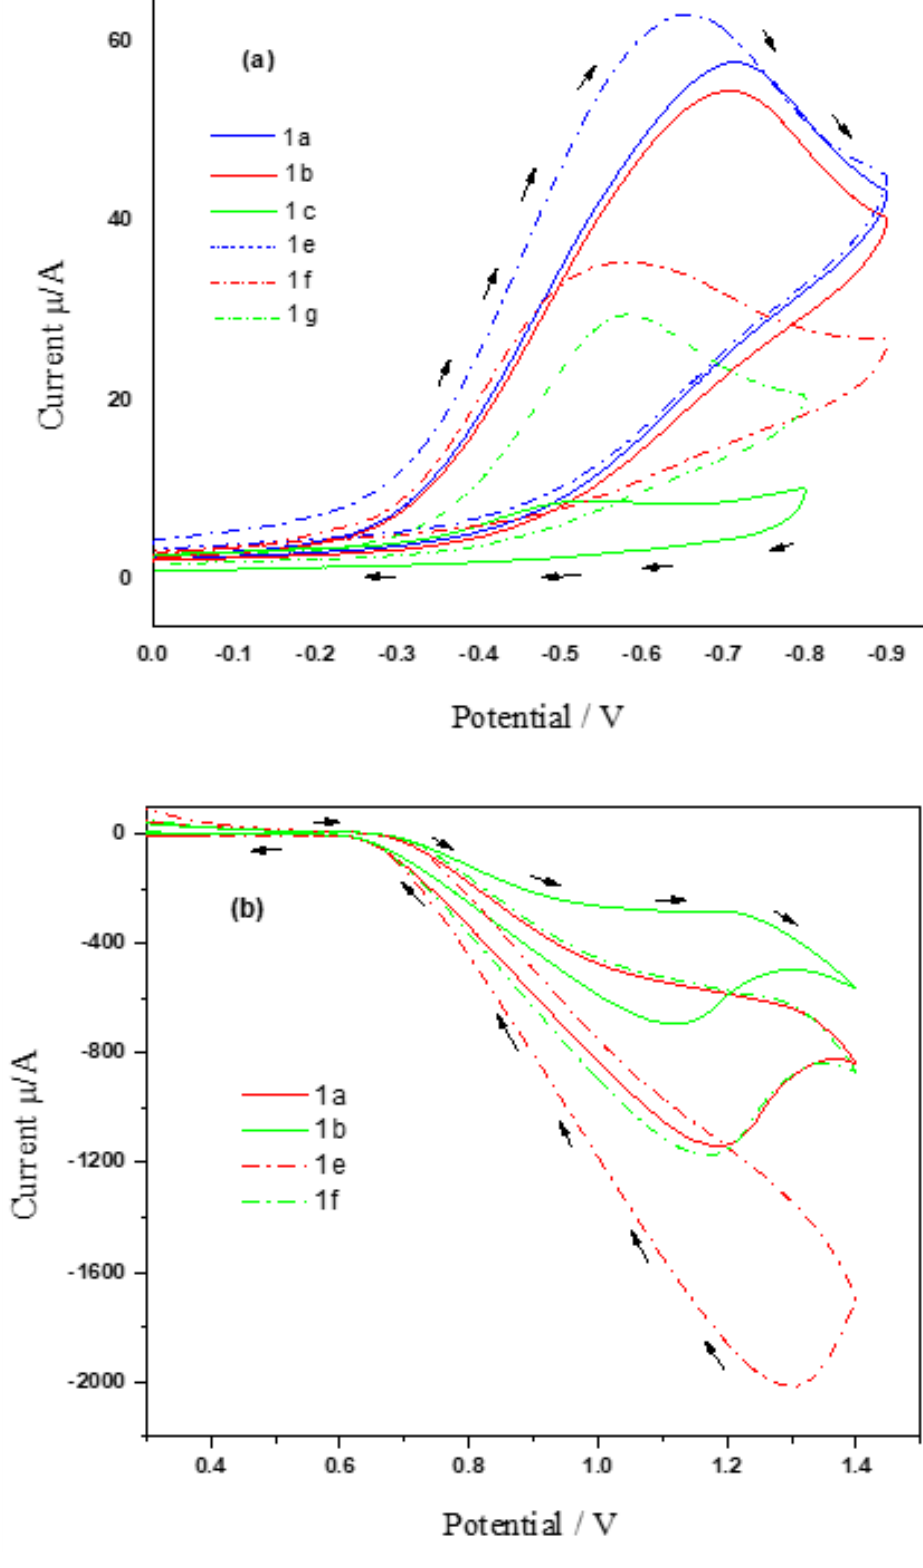
Figure 5. Cyclic voltammograms of metal(II) complexes 1a – h . ( a ) Reduction process at cathodic region. ( b ) Oxidation process at anodic region in DMF containing 0.1M of tetra(n − butyl)ammoniumperchlorate. The scan rate applied was 100 mVs −1 .